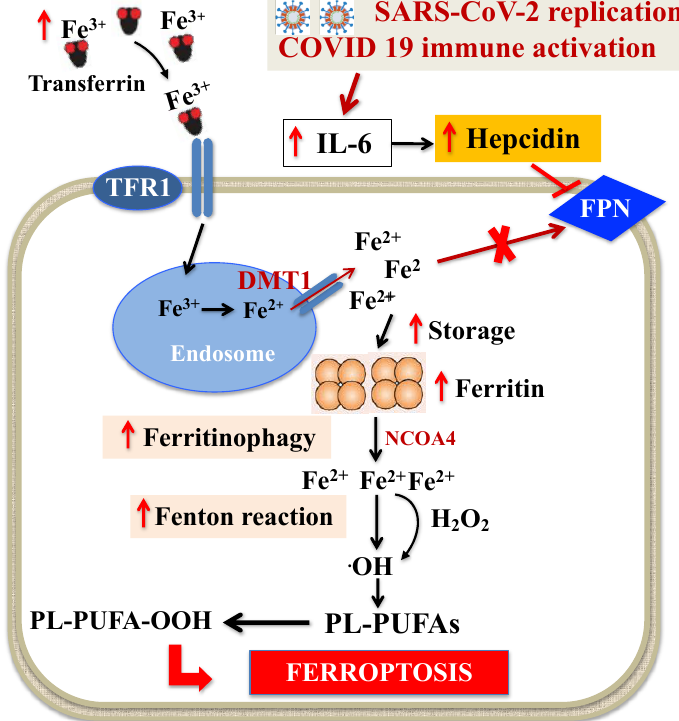
Figure 2. Dysregulation of intracellular iron metabolism in SARS-CoV-2 infection. Systemic immune activation induced by SARS-CoV-2 leads to profound changes in iron trafficking,